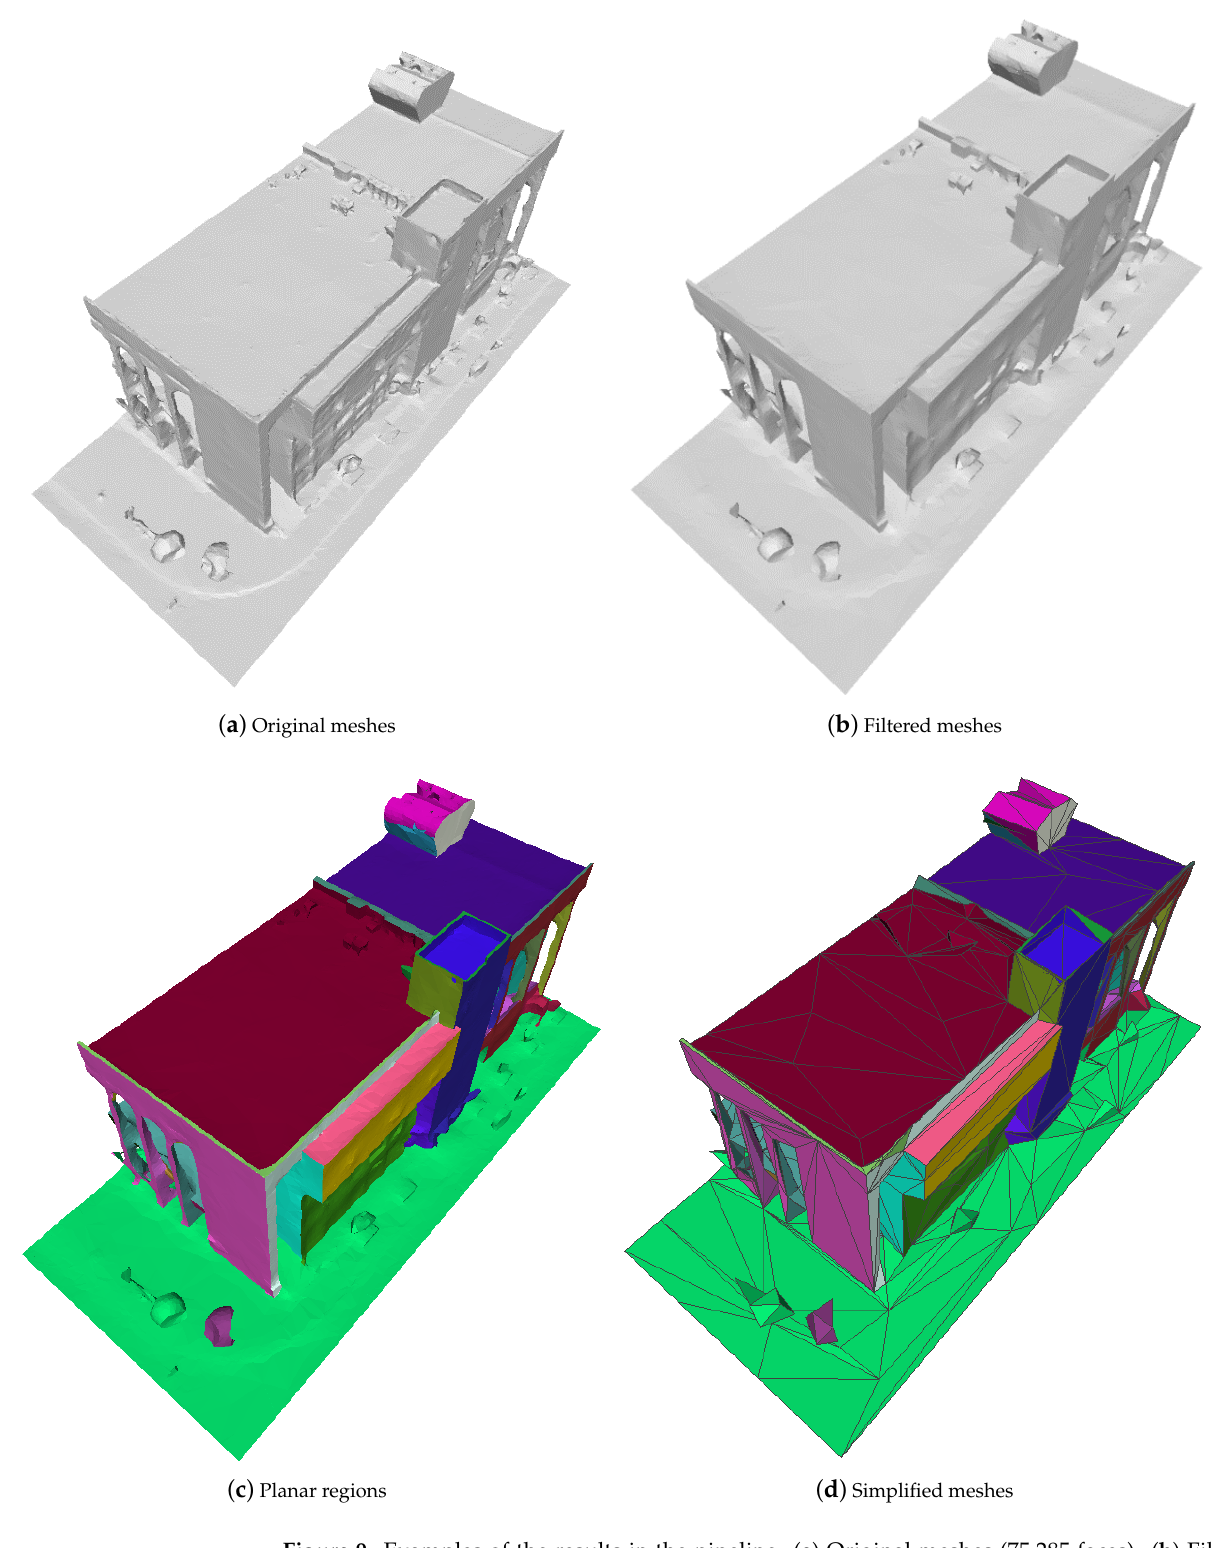
Figure 9. Examples of the results in the pipeline. ( a ) Original meshes (75,285 faces). ( b ) Filtered meshes. ( c ) Planar regions. ( d ) Simplified meshes (736